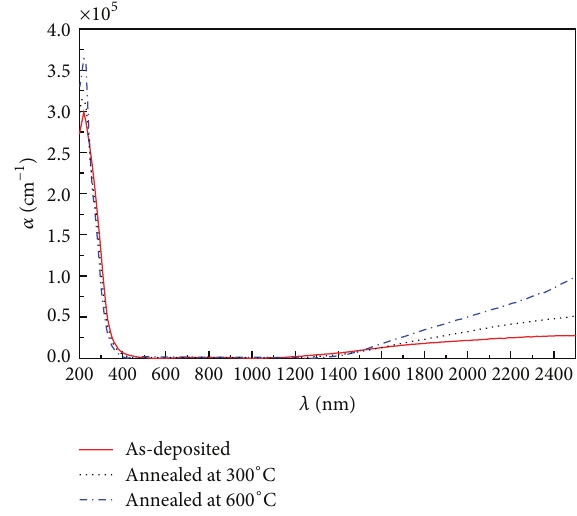
Figure 6: Dependence of the absorption coefficient of ITO thin films on the light wavelength for as-deposited and annealed